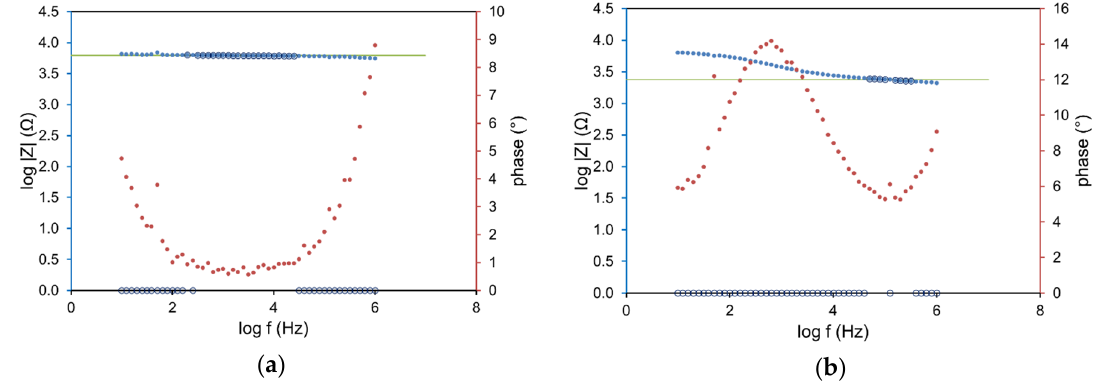
Figure 5. Curves of Bode-|Z| and Bode-phase obtained as an example in ( a ) reference mortar (REF) mortar and ( b ) GNP mortar.